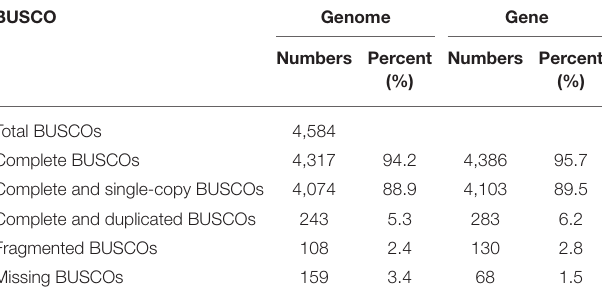
TABLE 2 | Evaluation of the genome and gene completeness with BUSCO.